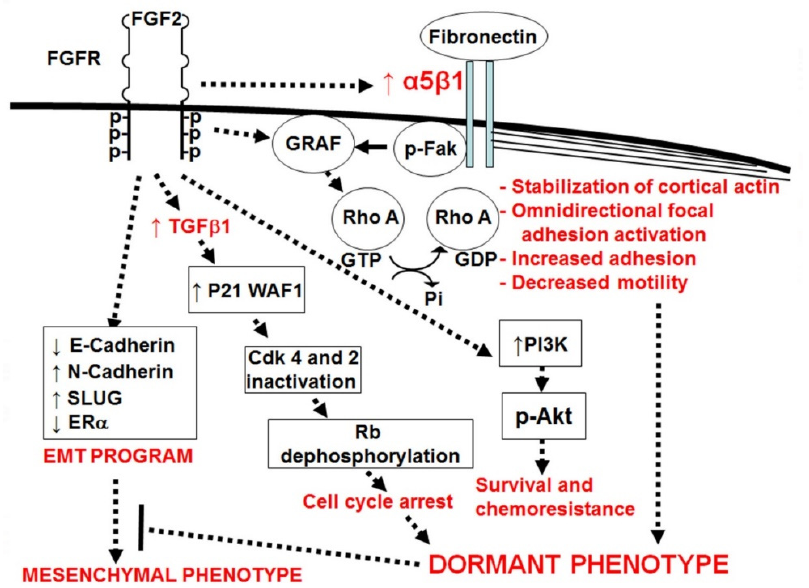
Figure 1. FGF-2 activates FGF receptors, inducing up-regulation of integrin α 5 β 1, which in turn binds stromal fibronectin [79]. FGF-2 induces cell cycle inhibition through increasing TGF β 1 [98], up-regulation of cyclin-dependent kinase inhibitors p21 Waf1/Cip1 , p15 INK4b and p27 Kip1 [97,98], inactivation of Cdk4 and 2 and dephosphorylation of Rb [97]. It induces survival and chemoresistance through activation of PI3K and Akt [79,95]. It induces an epithelial-like dormant phenotype through dual signaling with integrin α 5 β 1 to induce omnidirectional focal adhesion complex activation and increased adhesion [93,95]. FGF-2 and integrin α 5 β 1, in combination, activate the RhoGAP Graf, which is responsible for inactivation of RhoAGTP, causing cortical actin rearrangement and, together with increased adhesion strength, decreased motility [76,93,95]. FGF-2 also activates a mesenchymal program through decreasing E-cadherin and estrogen receptor α (ER α ) and up-regulating N-cadherin and SLUG [76]. However, the adhesion signaling suppresses the effects of the mesen- chymal program and results in a dormant phenotype [76].